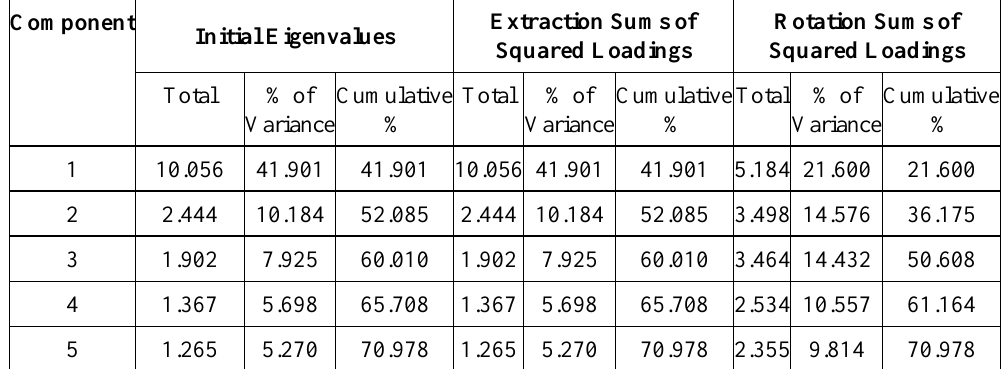
Table 8. Total Variance on the Factors Influencing Adoption of